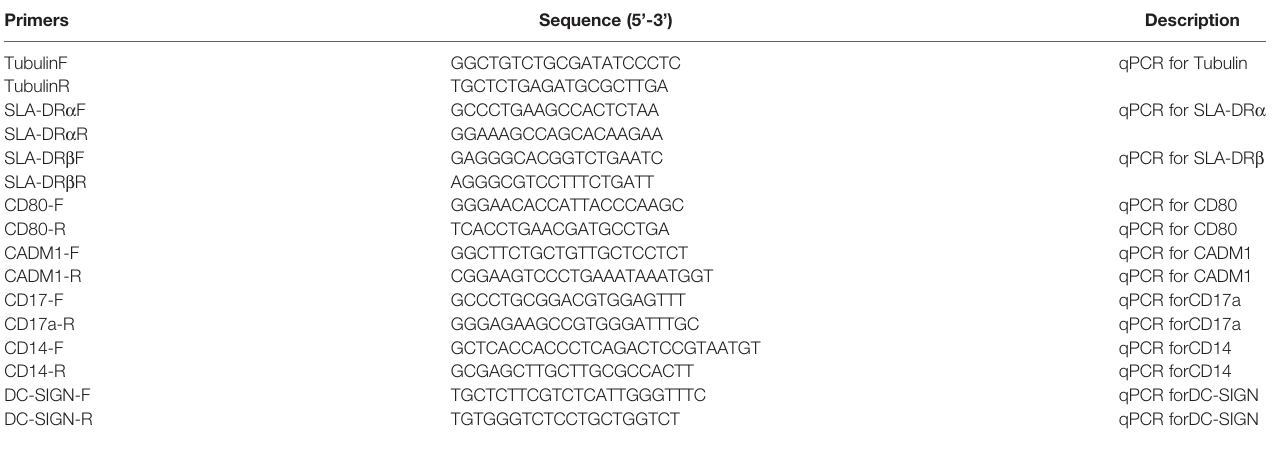
TABLE 2 | List of primers using for